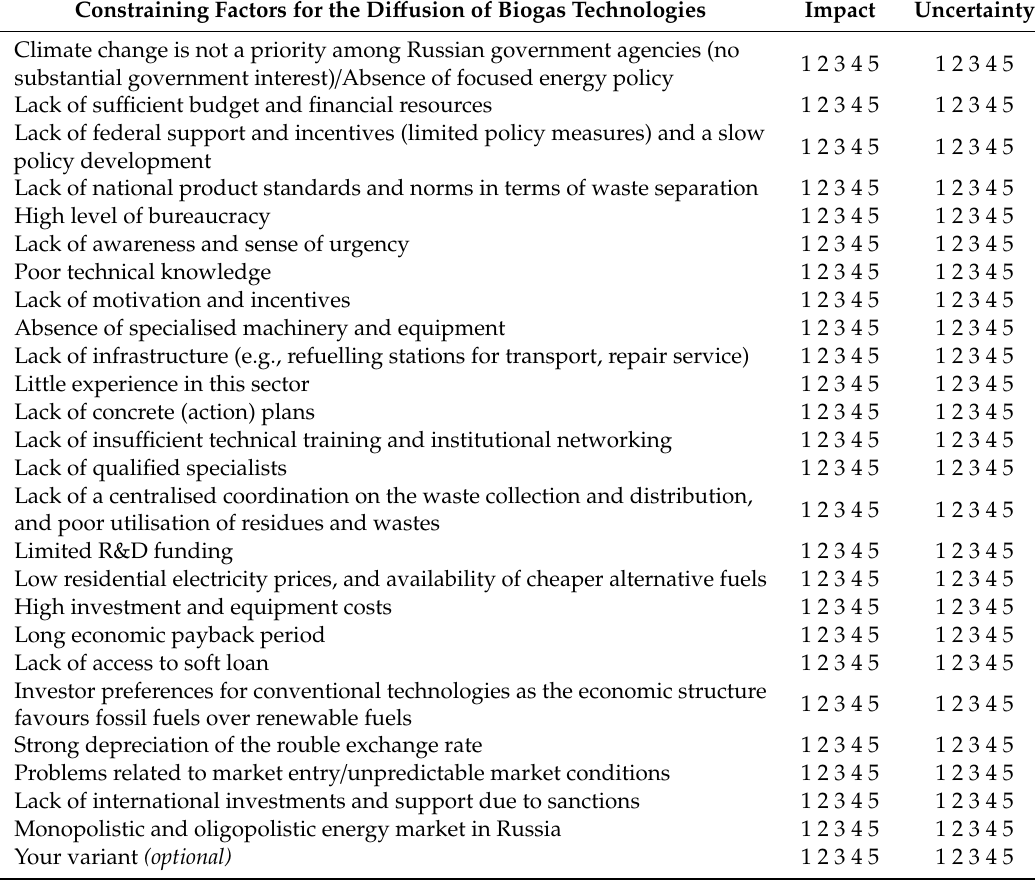
Table A3. Constraining factors for the di ff usion of biogas technologies in Russia.